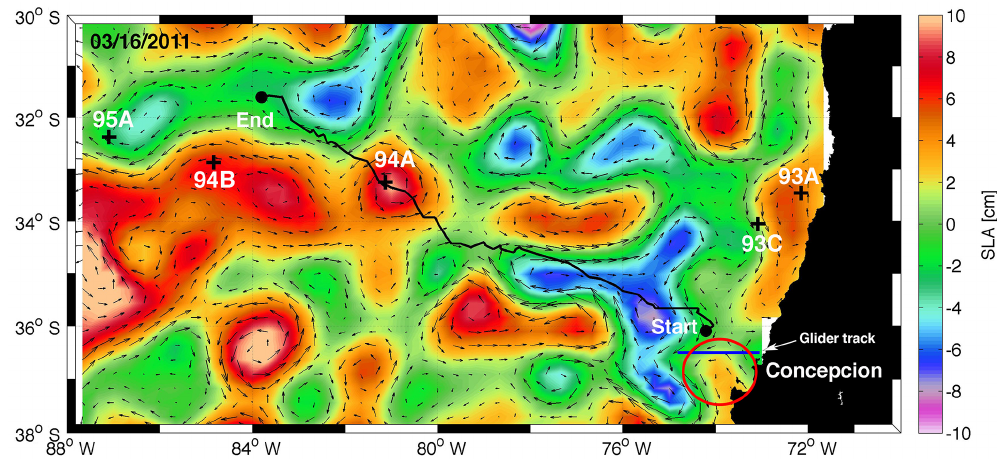
Figure 4. Sea surface hight from satellite data at the time of sampling in Tara station 094-A (March 2011). The position of the sampling stations (black crosses) and estimated eddy trajectory (black line) with start and end locations (black circles) of the trajectory are also indicated. The red circle off Concepción (36 ◦ S) shows the probable eddy generation zone.